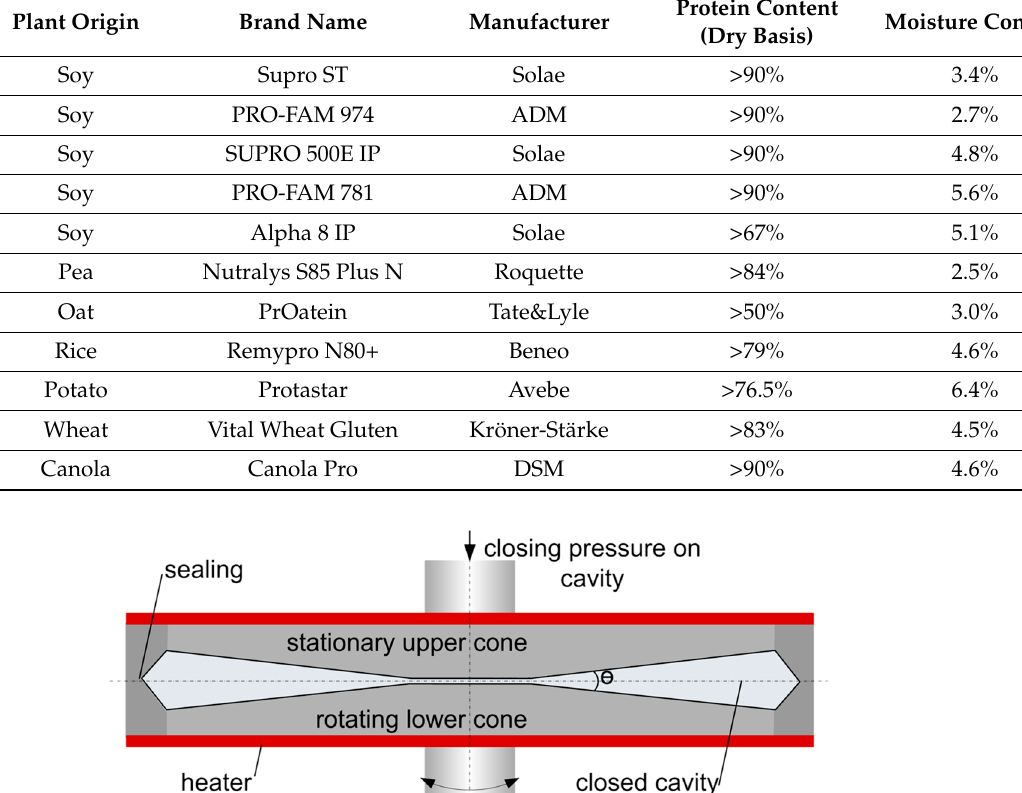
Figure 1. Closed cavity rheometer used for rheological measurements (picture taken from Emin & Schuchmann, 2017 [35]).